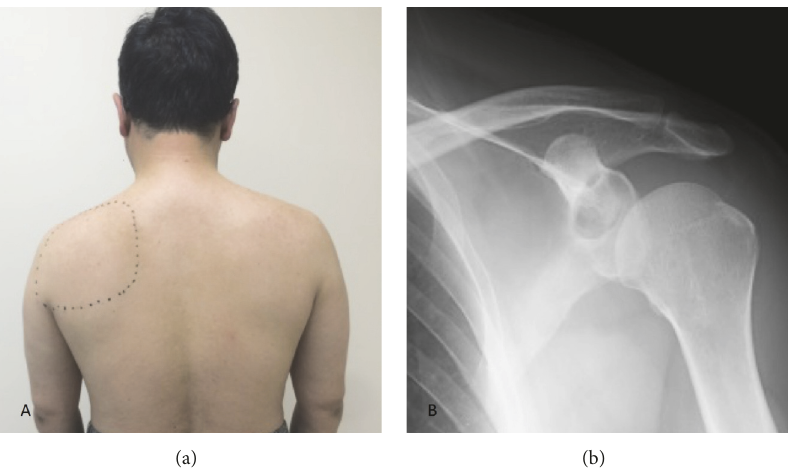
Figure 1: (a) Clinical photograph before the surgery shows a dotted circle at the left shoulder that indicates the area at which the patient complained of pain. The area includes the supra- and infraspinatus muscles and the suprascapular nerve. (b) Radiograph of the left shoulder shows a radiolucent cystic lesion in the superior